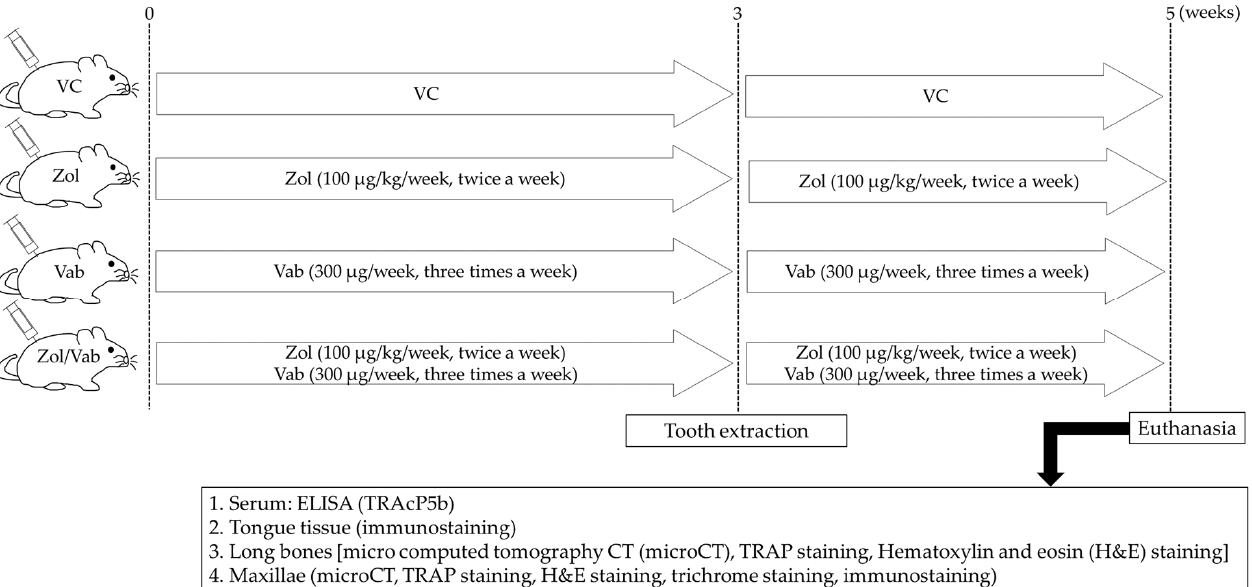
Figure 1. Experimental schedule. Zoledronate (Zol), anti-VEGF-A neutralizing antibody (Vab), and their combination (Zol/Vab) are administered for 5 weeks. Tooth extraction and euthanasia are carried out 3 and 5 weeks, respectively, after onset of drug administration.